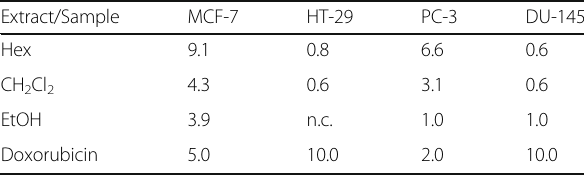
Table 6 Selectivity index of extracts and positive control